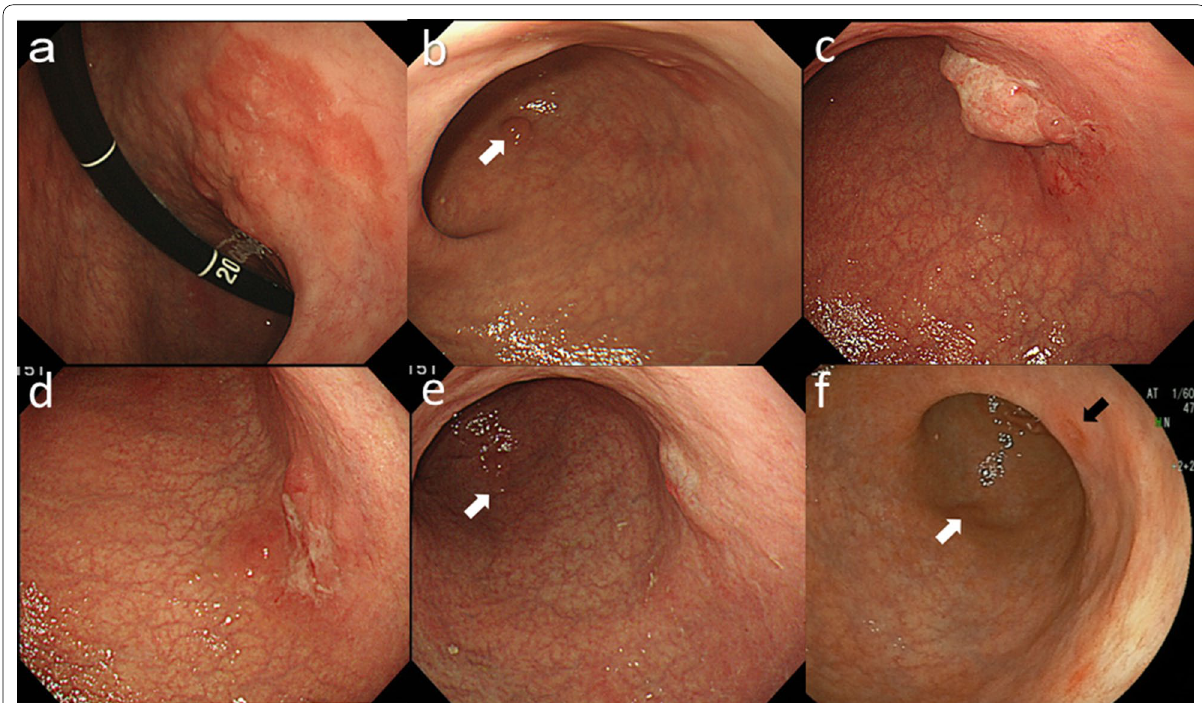
Fig. 1 Esophagogastroduodenoscopic findings. a Pretreatment: a type 0–IIc tumor in the posterior wall of the gastric angle. b Pretreatment: adenoma in the greater curvature of the gastric antrum (white arrowhead). c After fifth-line chemotherapy, the tumor grew to type 3 in the posterior wall of the gastric angle. d After eighth-line chemotherapy, the type 3 tumor remained in the posterior wall of the gastric angle. e After nivolumab, redness and smooth elevation of the posterior wall of the angle were seen and the biopsy revealed no malignancy. Adenoma in the greater curvature of the gastric antrum seemed stable (white arrowhead). f Forty-two months after nivolumab, a type 0–IIc tumor appeared in the lesser curvature of the gastric angle (black arrowhead). Biopsy showed adenocarcinoma. Adenoma in the greater curvature of the gastric antrum (white arrowhead) was found to be